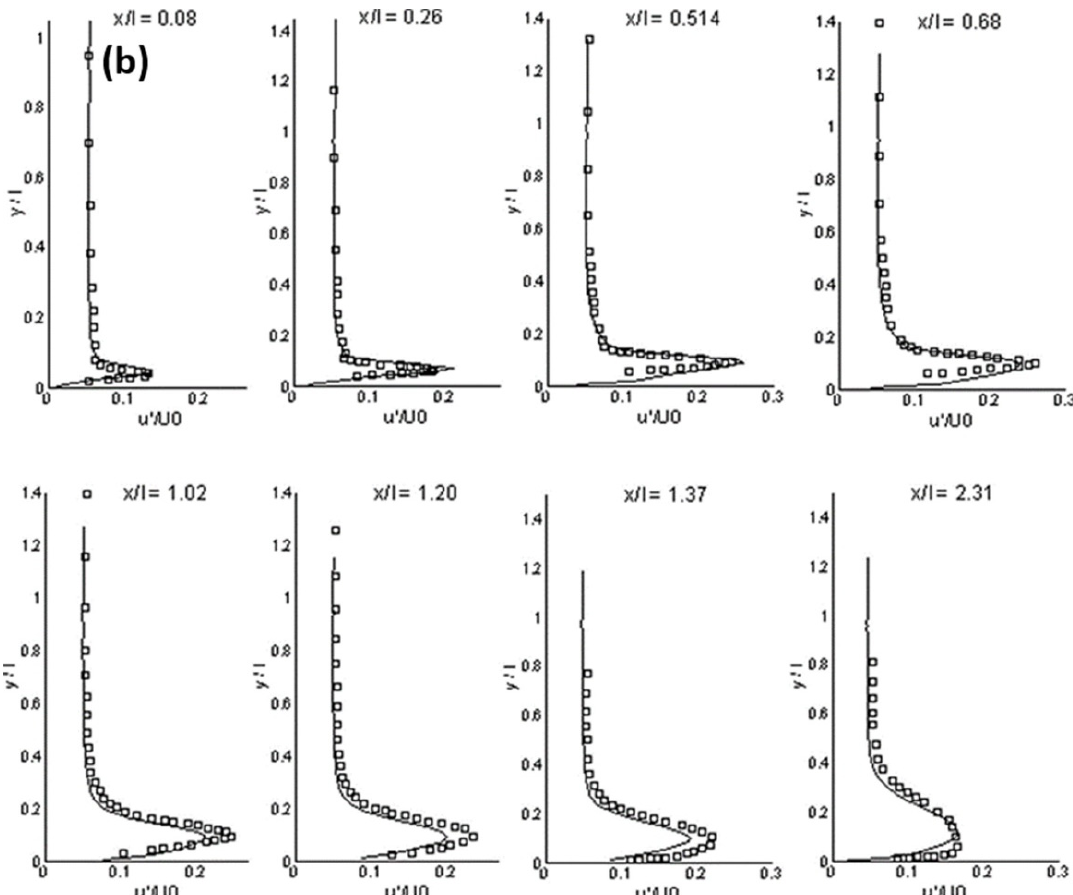
Figure 1. ( a ) Mean streamwise velocity, ( b ) rms streamwise velocity at different streamwise stations (ETL-case) (LES: solid lines, experimental data: symbols, x/l: normalized streamwise, y/l: wall-normal direction, U/U 0 : normalized mean streamwise velocity, u’/U 0 : normalized rms streamwise velocity) [126].